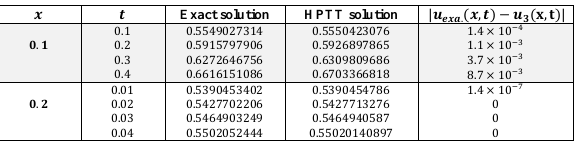
and Table 2 that exact solution for given problem 5.1 is in close agreement with 3 rd order HPTT solution. Here only 3 rd order HPTT solution is used to calculate the numerical solution and HPTT can yield more accurate solution with less absolute error by computing higher order approxima-